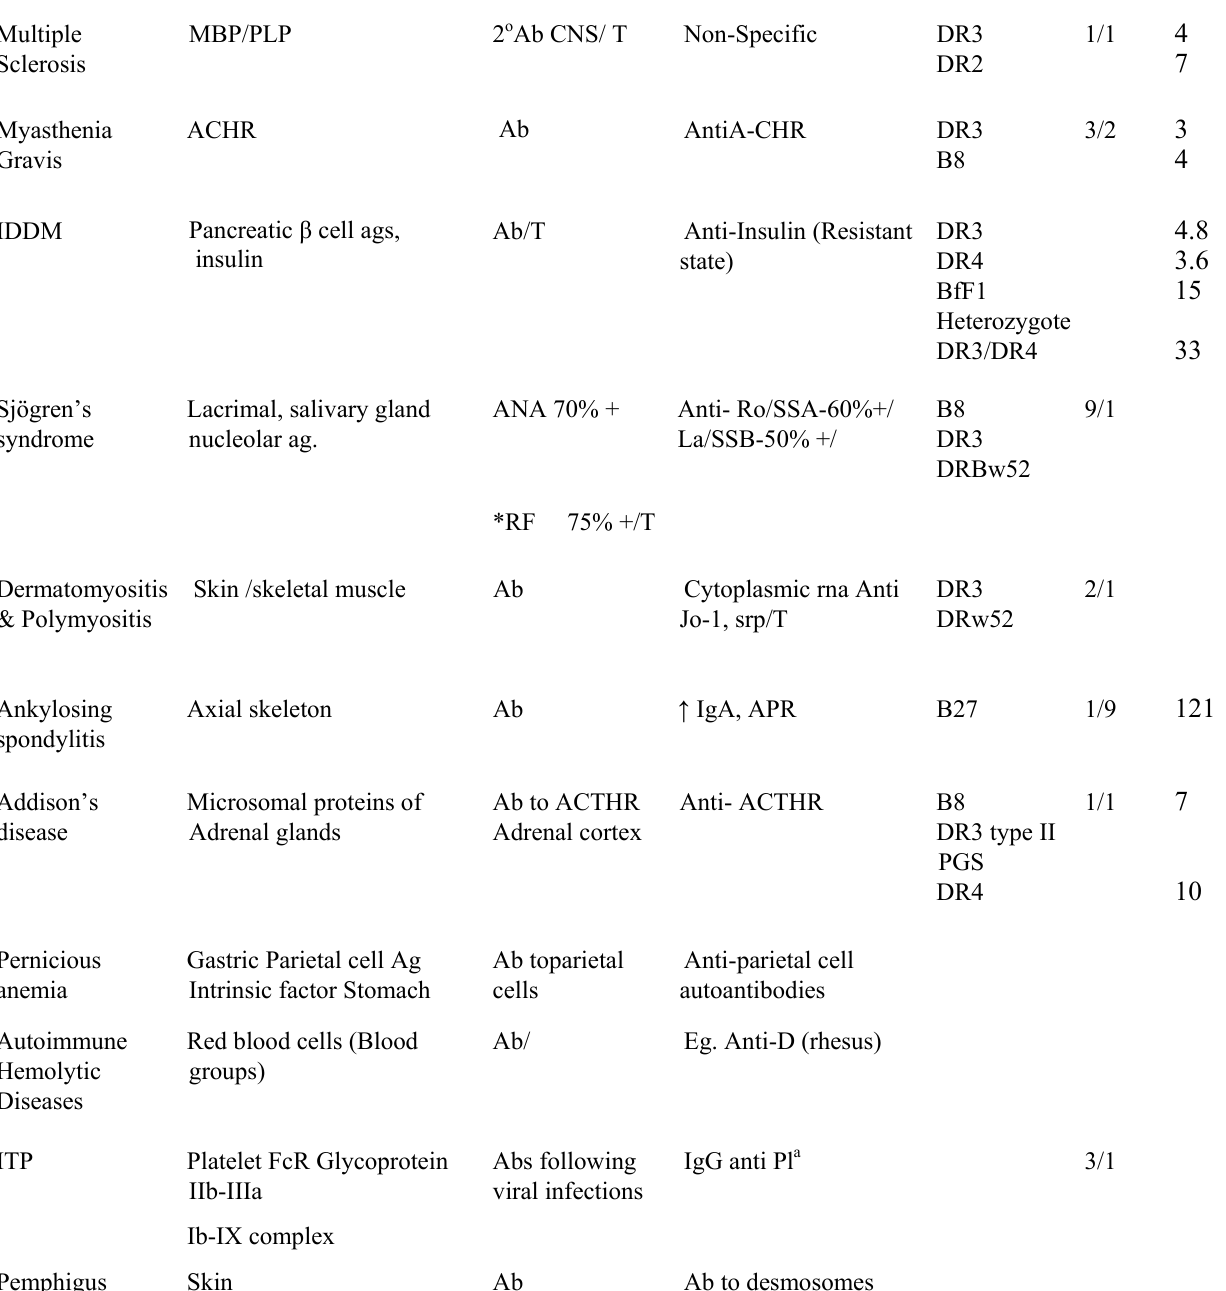
antibody; Ag, antigen; Anti GBM, anti glomerular membrane; ANA, anti nuclear autoantibodies; ACHR, acetylcholine receptor; ACTHR adrenocorticotrophin hormone receptor; ADCC, antibody dependent cell cytotoxicity; APR, acute phase action; CREST, Calcinosis, Raynaud’s phenomenon, esophageal dysmotility, sclerodactyly, telangiectasia; APR, Acute hase reactants; F/M, female/male; C-ANCA-cytoplasmic antineutrophil cytoplasmic antibodies: antiproteinase Wegener’s granulomatosus); ITP, Idiopathic thrombocytopenic purpura; RA, rheumatoid arthritis; SLE, systemic lupus rythematosus; MBP/PLP, myelin basic protein/proteolipid pro ein; P-ANCA, perinuclear antimyeloperoxidase; (SLE, olyarthritis); PAN, polyarteritis nodosa; PDC-pyruvate dehydrogenase complex (E2 component = dihydrolipoamide cetyltransferase); PGS, polygrandular syndrome; NS, non-specific; Srp, signal recognition particle; RR*, Relative Risk MHC class II antigen related); TSHR, thyroid stimulating hormone receptor; T, T-cell or cellular responses; TSHR, hyroid stimulating